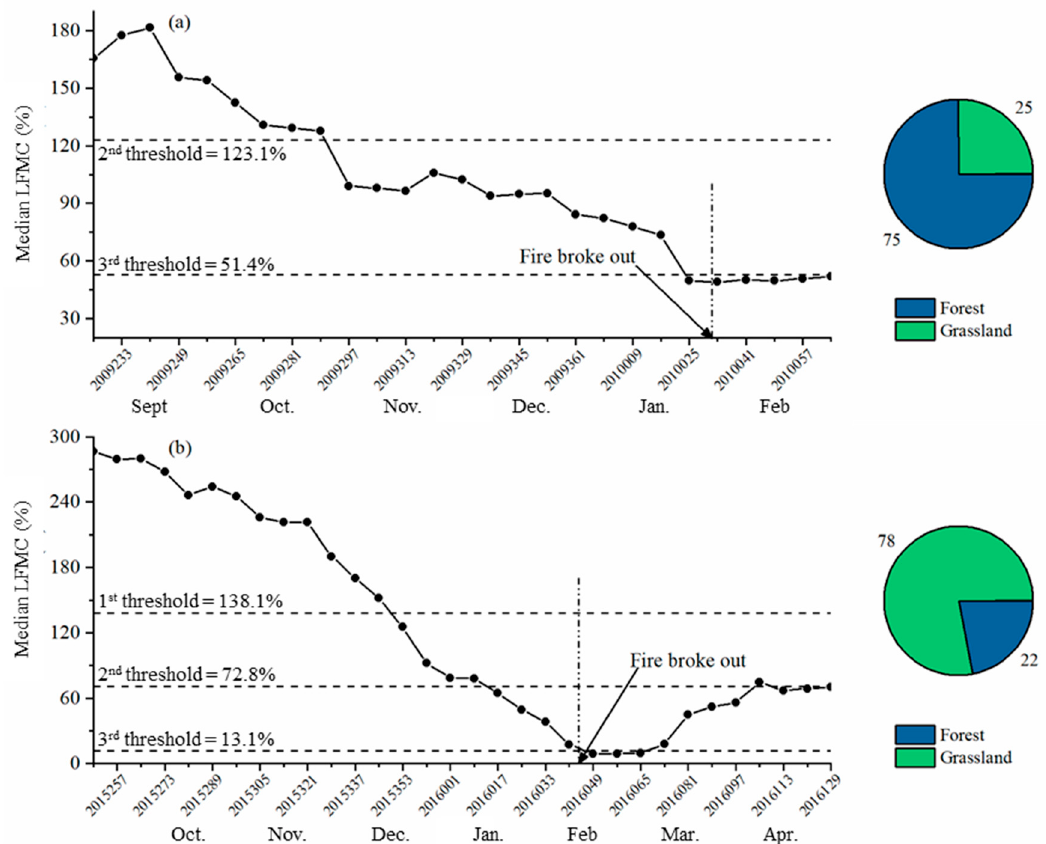
Figure 7. Temporal LFMC dynamics before and after the Qiubei ( a ) and the Lantern Mountain ( b ) fire events across the Cwa zone. The dotted lines represent the critical LFMC thresholds. The pie chart shows the percentage of the total burned area per land cover.